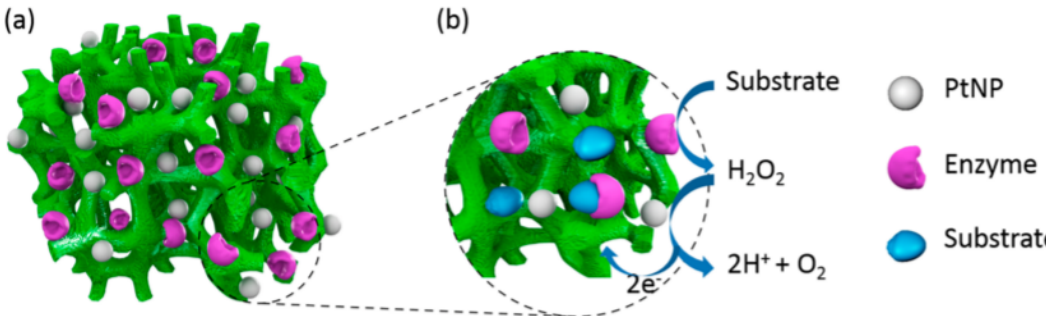
Figure 3. Schematic illustration of the general sensing mechanism of our CPH-based electrode platform. ( a ) PtNPs and enzymes were loaded onto hierarchically three-dimensional (3D)-porous PAni hydrogel matrices to form PAni hydrogel/PtNPs hybrid electrodes. ( b ) The PtNP-catalyzed sensing process of the biosensor based on PAni/PtNPs/enzyme hybrid films. Reprinted from Reference [55] with permission from the American Chemical Society.